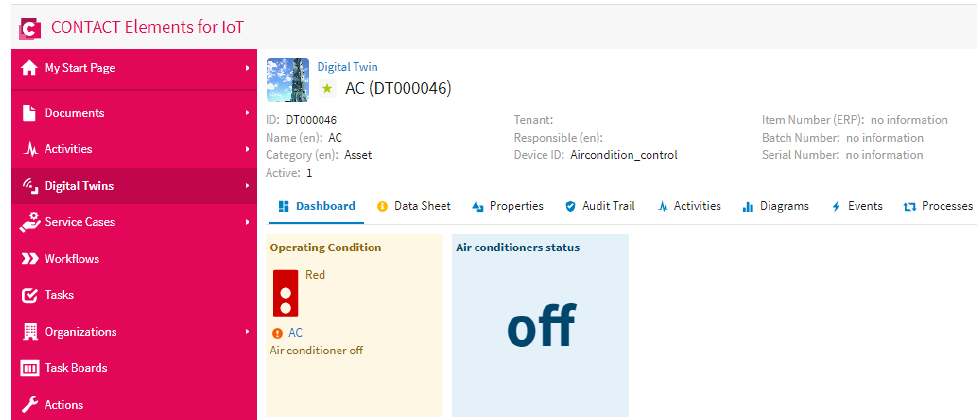
Figure 15. The number of persons detected in the case of scenario 3: ( a ) the output of YOLOv3 algorithm, ( b ) the presented output on the dashboard of the IoT platform.